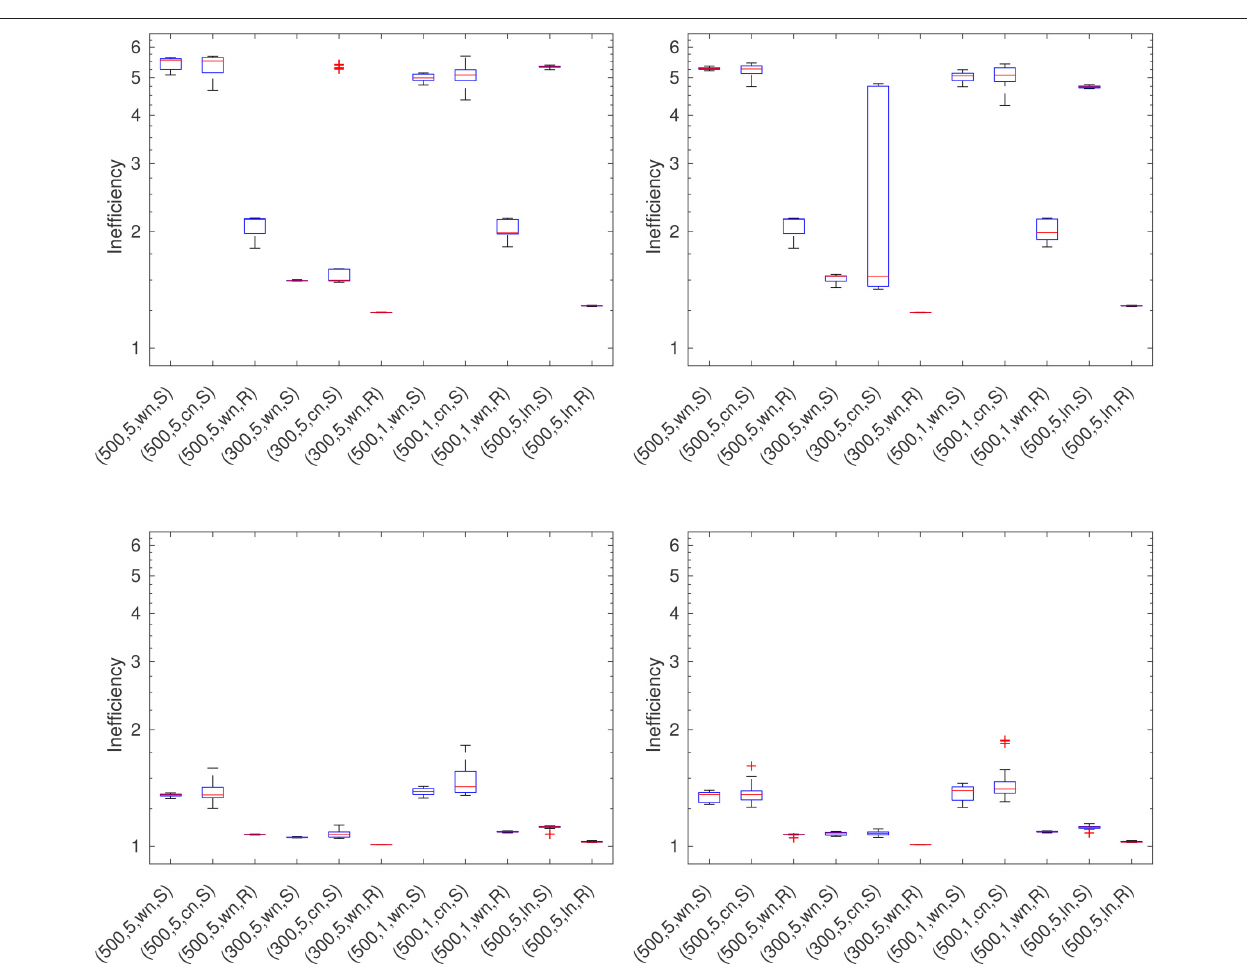
FIGURE 6 | EEM for the RFMP (Left-hand top) and the ROFMP (Right-hand top) and RM for the RFMP (Left-hand bottom) and the ROFMP (Right-hand bottom) .